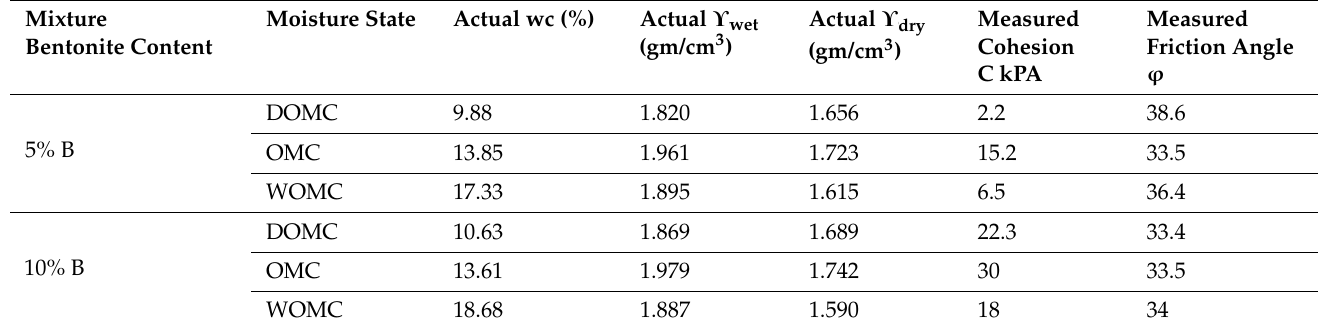
Table 2. Compaction and shear strength properties of tested samples of clay–sand mixtures.